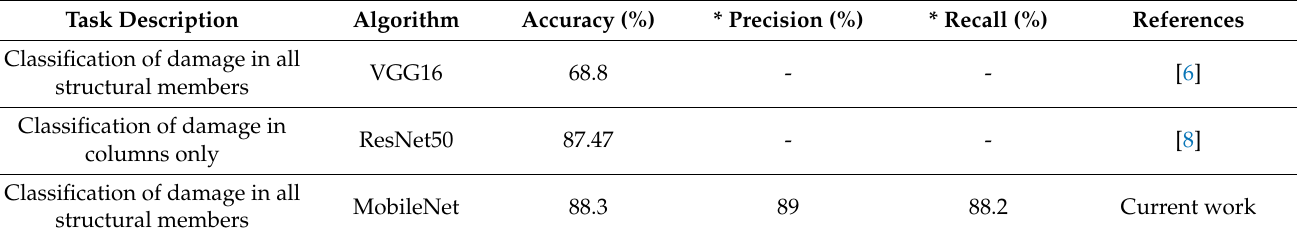
Table 5. CNN-based SD classification models compared with current